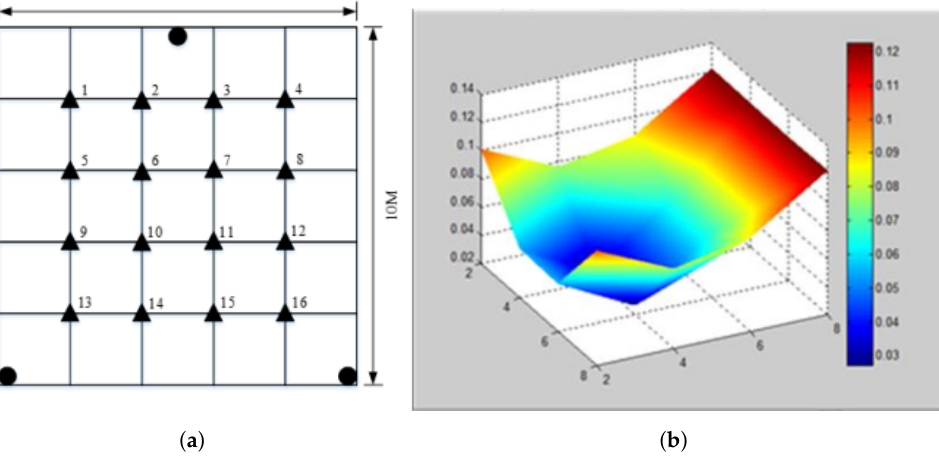
Figure 8. ( a ) UWB localization accuracy test; ( b ) error distribution.